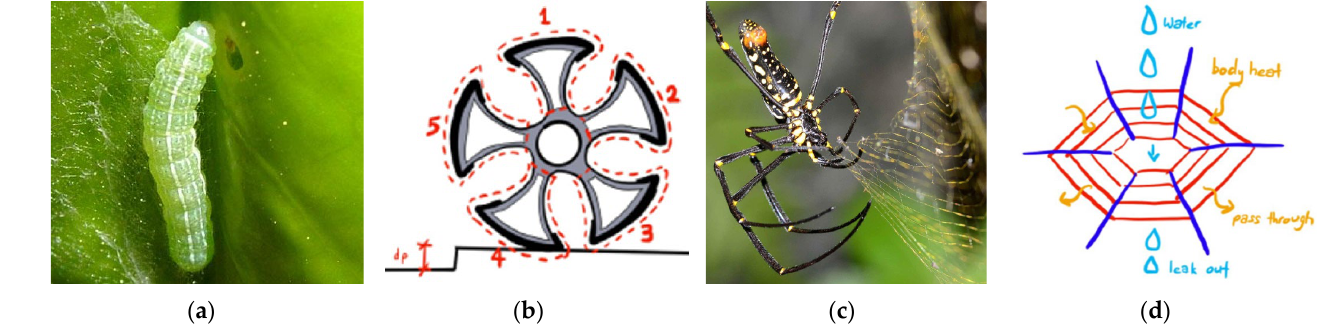
Figure 11. ( a ) Leaf roller caterpillar. ( b ) Sketch of a wheel mimicking leaf roller. ( c ) Golden orb web spider Nephila pilipes. ( d ) Sketch of a woven pattern mimicking the spider web patterns. Photos: ( a ) [32], ( c ) [33], Illustrations: ( b , d ) [34].